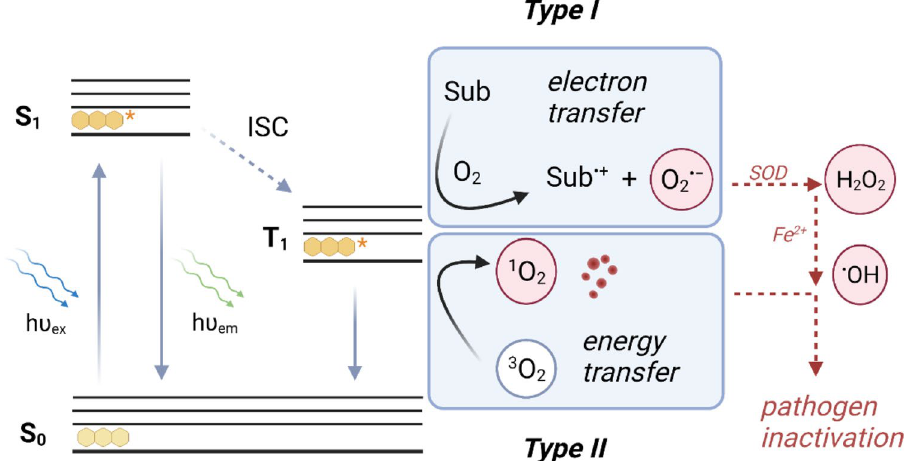
Figure 1. Mechanism of photosensitised reactive oxygen species (ROS) formation that enables inactivation of pathogens. ISC = intersystem crossing, Sub = substrate, SOD = superoxide dismutase.